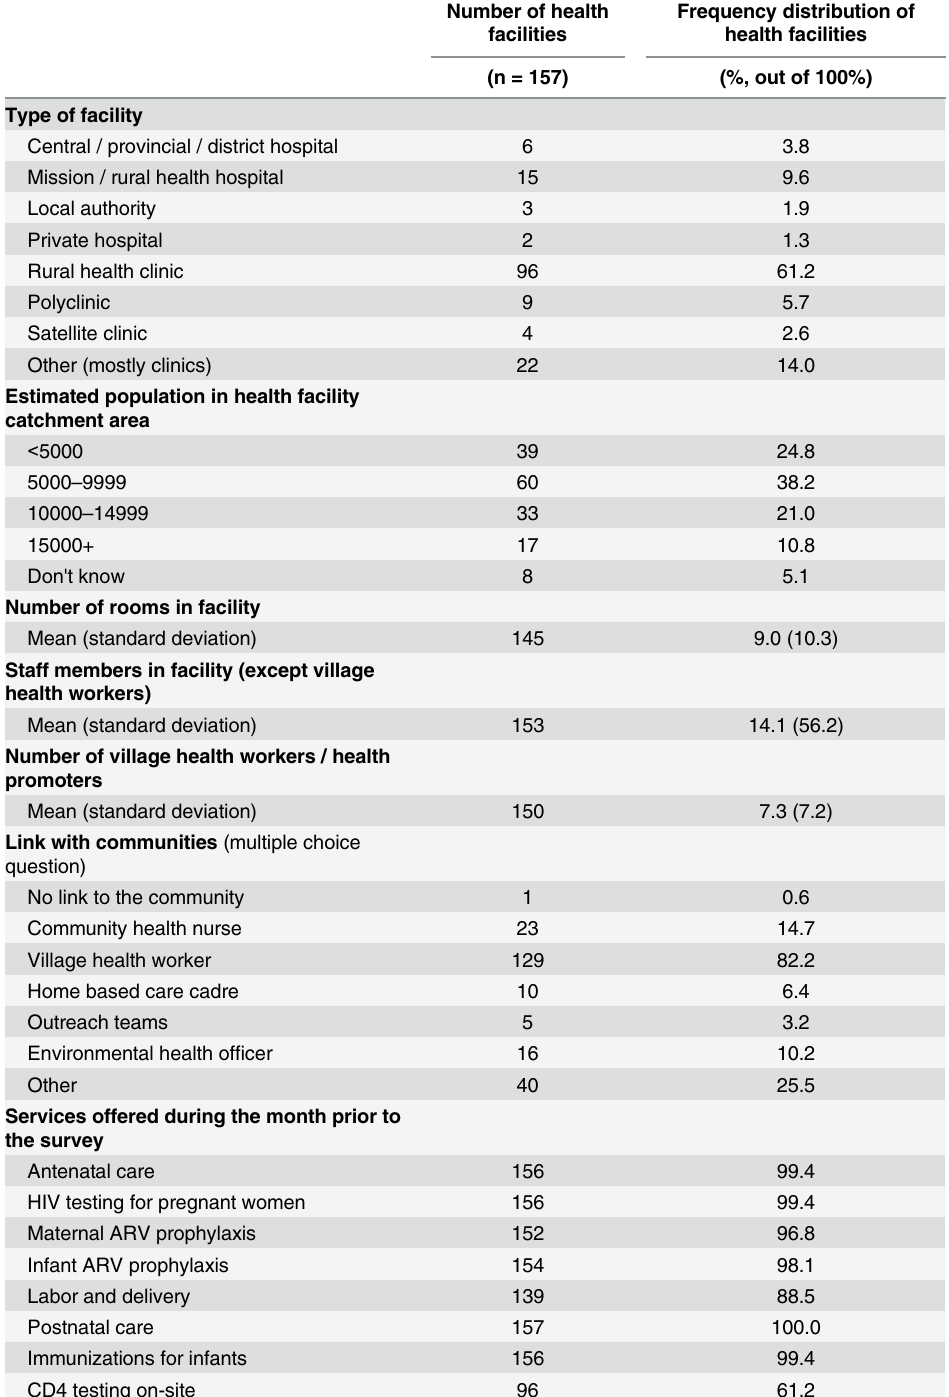
Table 1. Characteristics of sampled health facilities in five provinces, Zimbabwe,